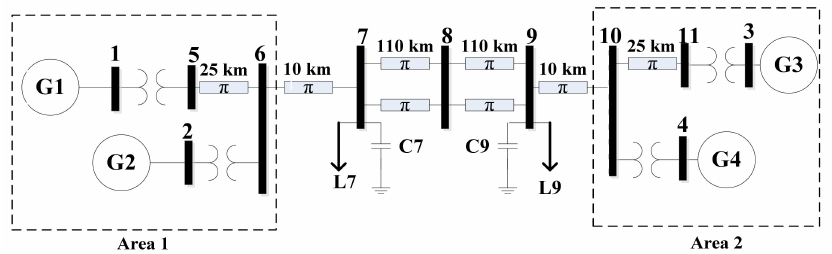
Figure 4. The two-area four-machine power system.